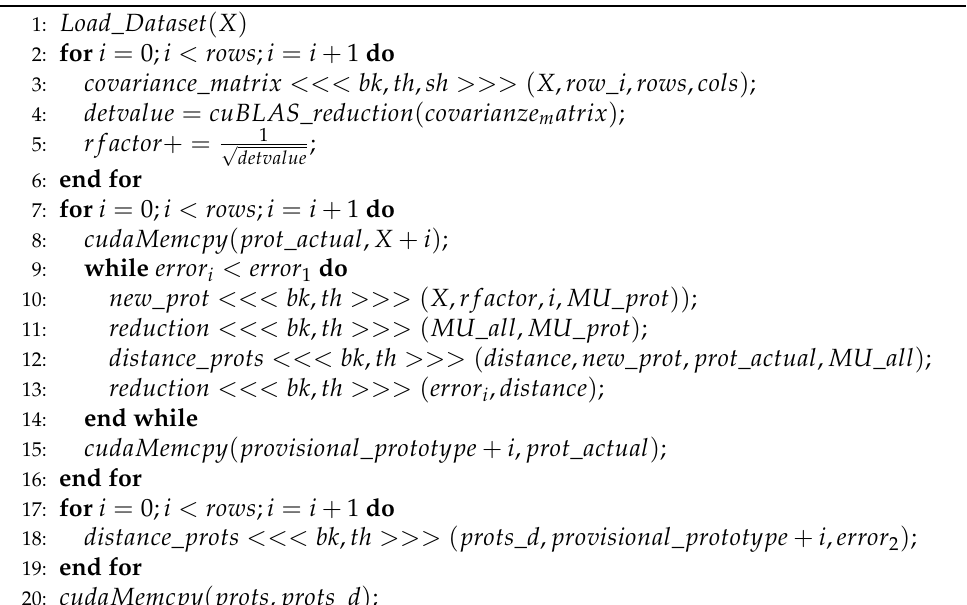
Algorithm 12: R Factor and Prototype calculation algorithm in